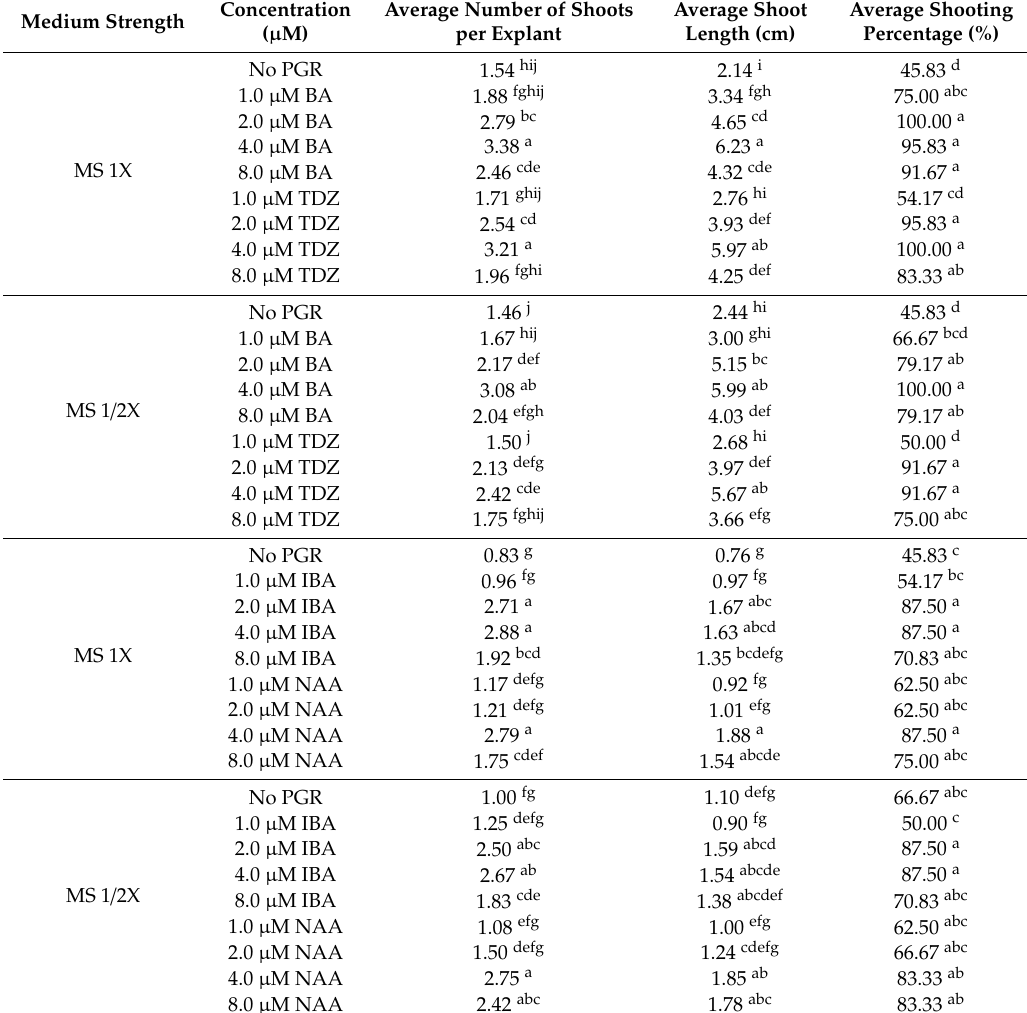
Table 2. The e ff ect of medium strength and plant growth regulators’ concentrations on the average number and length of shoots per explant, shoot formation frequency, as well as on number and length of roots per shoot and rooting percentage of the high cannabigerol (CBG) Cannabis sativa variety. (Means followed by the same letter do not di ff er statistically at p ≤ 0.05 according to Duncan